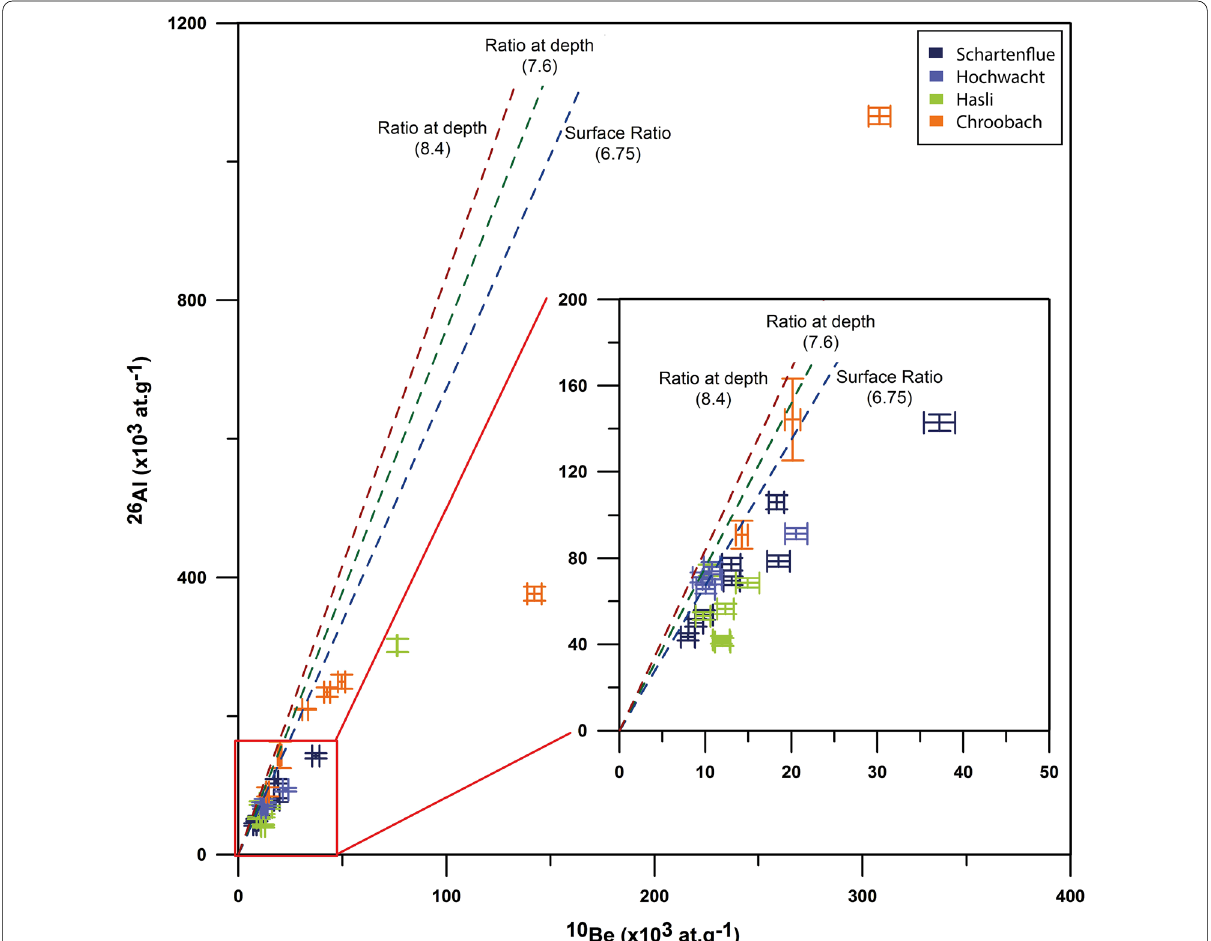
Fig. 13 Measured cosmogenic 10 Be concentrations plotted against measured cosmogenic 26 Al concentrations. The dashed lines mark the initial 26 Al/ 10 Be ratios at the surface (6.75) and at depth (7.6 and